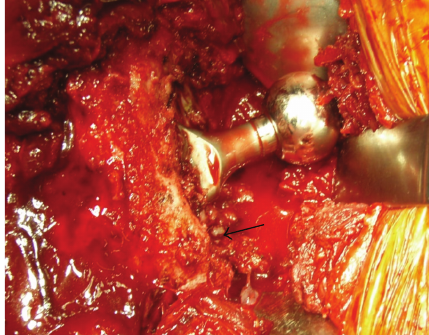
Figure 3: Intraoperative photograph at revision surgery showing granulation tissue at the femoral bone-stem interface (arrow), but no corrosion at the head-neck junction.